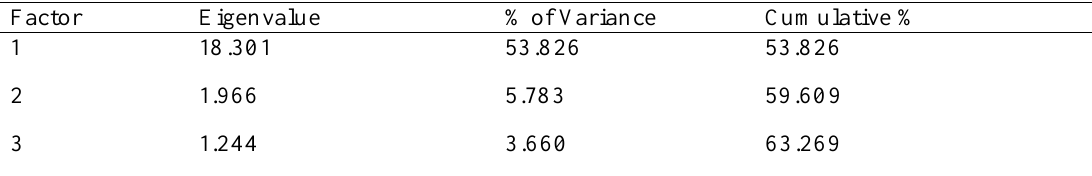
Factor Analyses